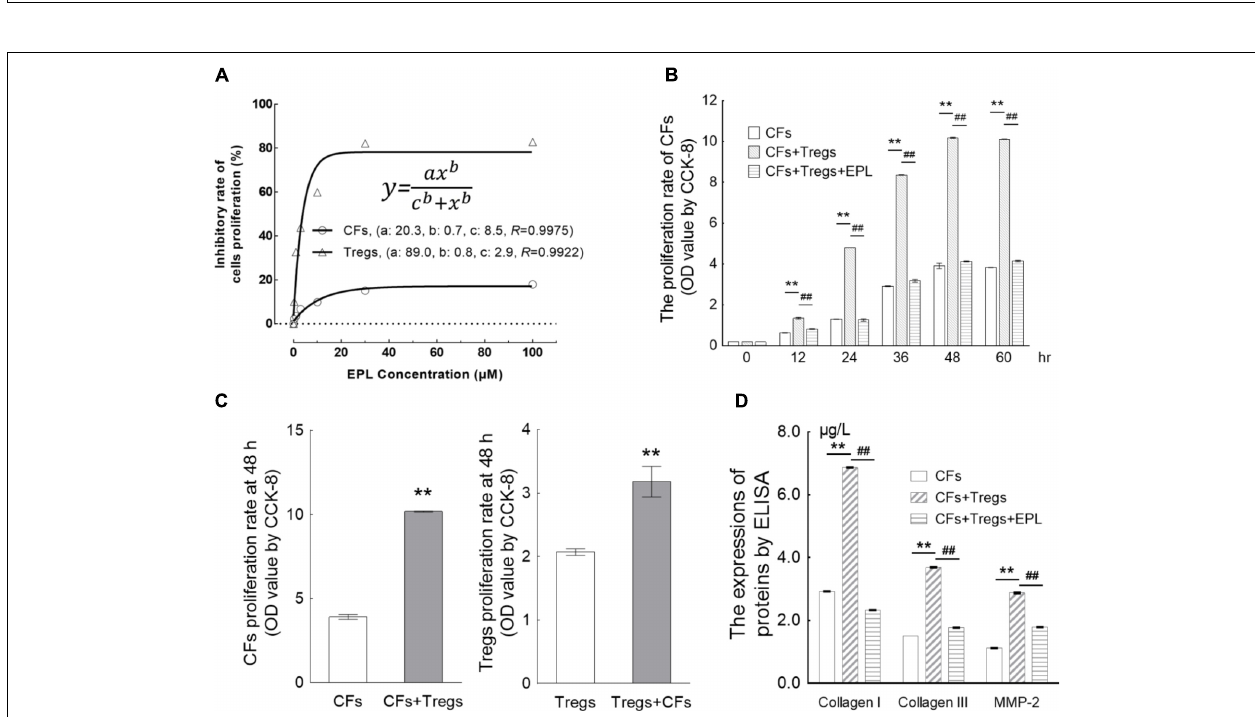
FIGURE 4 | Eplerenone suppresses the Kv1.3 current, which is elevated in the CHF model. The ramp line was elicited with whole-cell patch clamp mode. The ramp protocol stimulation is sustaining from –80 mV to +40 mV of 300 ms duration applied every 30 s. (A) The original current density trace elicited from Tregs of the CHF rats was significantly higher than that of Tregs from the control rats ( n = 10 cells for each group); 30 µ M eplerenone (EPL) markedly suppressed the ramp line of the Kv1.3 current density in the CHF model rats (the black traces are averaged dots of the current density and the dotted lines are standard error bars). (B) At +40 mV in particular, the current density was ∼ 5-fold higher in the CHF rats than in the control rats ( ∗∗ P < 0.01); the suppression of the current density by EPL was calculated as ∼ 67% comparing to the CHF rats ( ## P < 0.01).